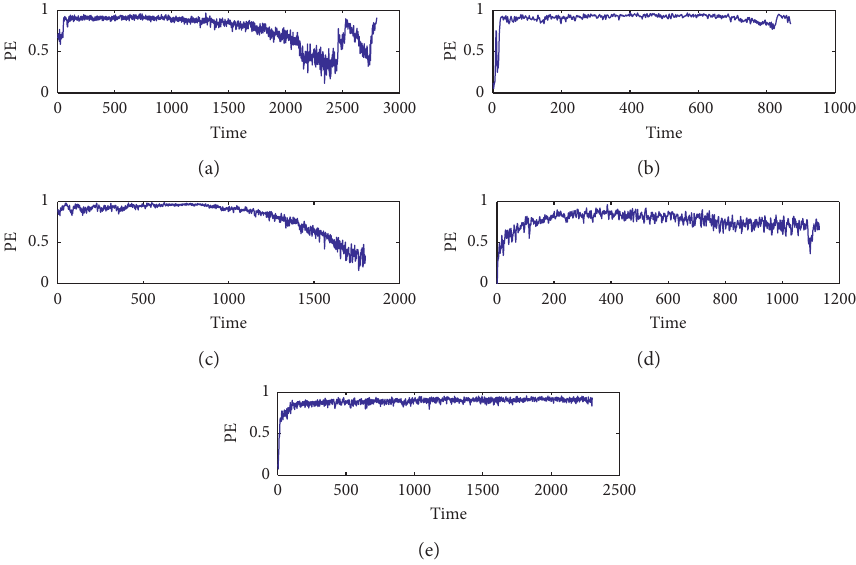
Figure 28: CVs for bearings 11–15 by using PE. (a) Bearing 11. (b) Bearing 12. (c) Bearing 13. (d) Bearing 14. (e) Bearing